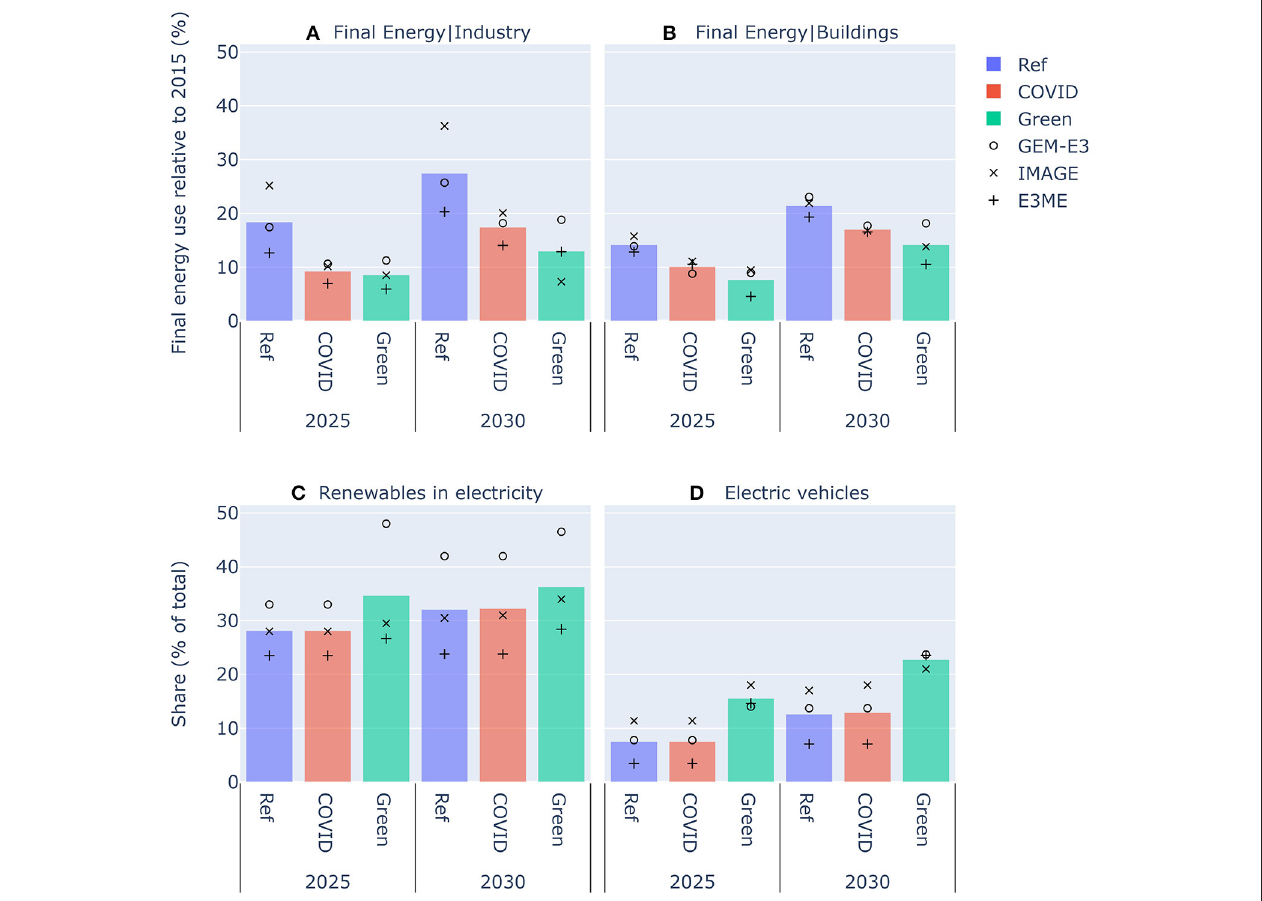
FIGURE 3 | Selected global energy system indicators. Projected changes in selected global energy indicators, for 2025 and 2030 (x-axis), for all scenarios (color). (A,B) Final energy use in the industry and buildings sector respectively, relative to 2015 (%). (C) Share of renewables in electricity production (% of total). (D) Share of electric vehicles (% of total). Symbols indicate individual model results. The bars indicate model mean and were added for reporting reasons.